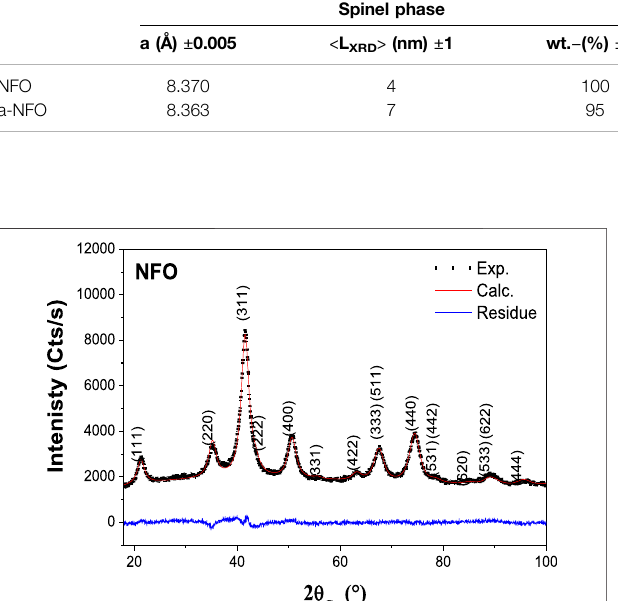
TABLE 1 | Main structural and microstructural characteristics of NFO and a-NFO powders as deduced from XRD analysis. Typically the cell parameter, a; the average coherent diffraction domain size, < L XRD > ; and the weight content, wt. of each constituting phase are indicated. Spinel phase Other phase